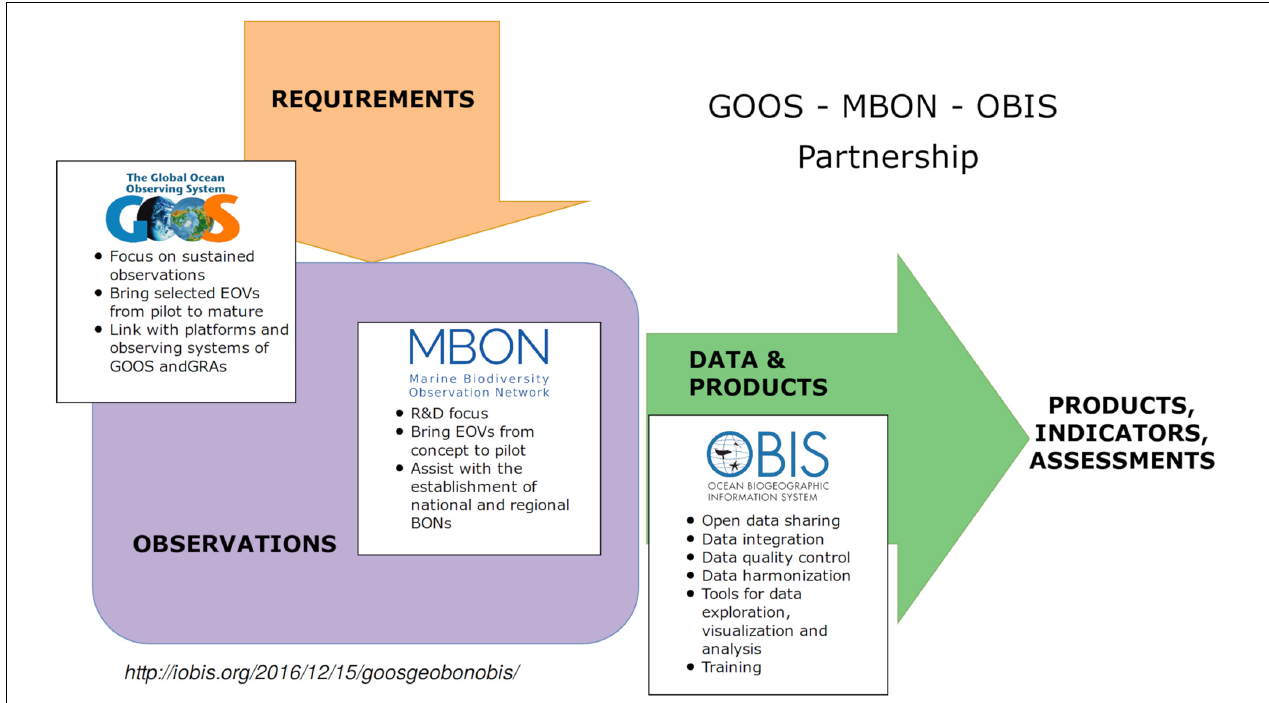
FIGURE 1 | Information flow diagram as part of the GOOS-MBON-OBIS collaboration agreement, (http://iobis.org/2016/12/15/goosgeobonobis/), helping to work toward an international integrated system for marine biological observations. The aim of this collaboration is to build a globally coherent, consistent, and coordinated sustained global ocean observing system (GOOS) to assess the state of the ocean’s biological resources and ecosystems.